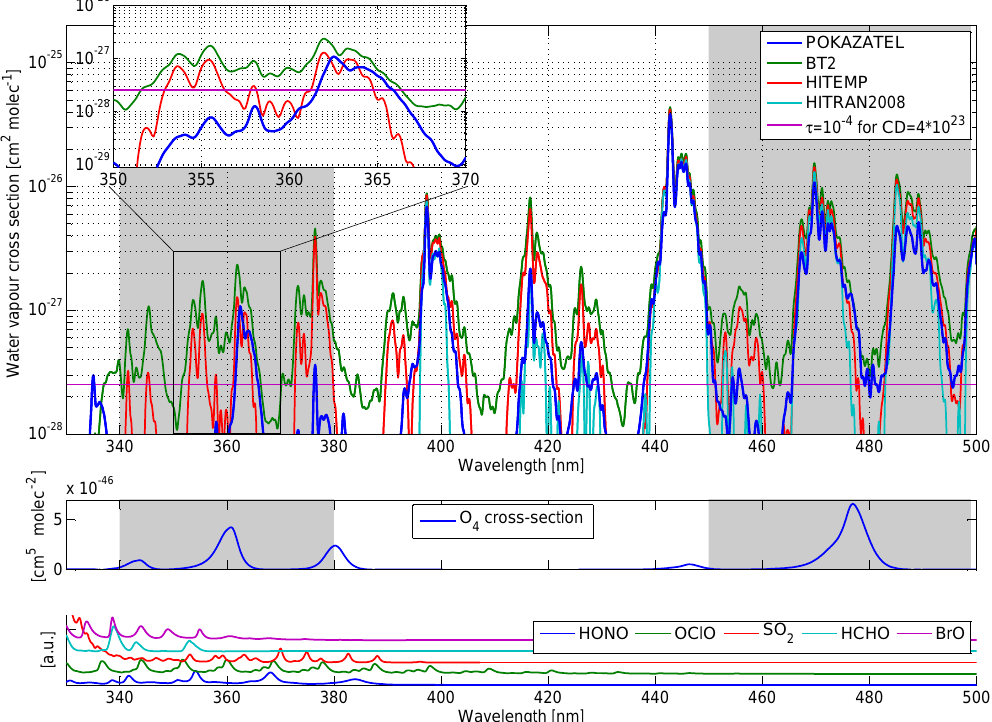
Figure 1. Overview of some recently published water vapour cross sections convoluted to a spectral resolution of 0.5nm in the spectral interval from 330 to 500nm. Also indicated is a typical MAX-DOAS detection limit for a differential optical density (OD) of 10 − 4 at a water vapour column density of 4 × 10 23 (purple line, top panel). The middle panel shows the O 4 absorption cross section and the lowermost panel shows other absorbers of atmospheric relevance (HONO, OClO, SO 2 , HCHO, and BrO) in this spectral